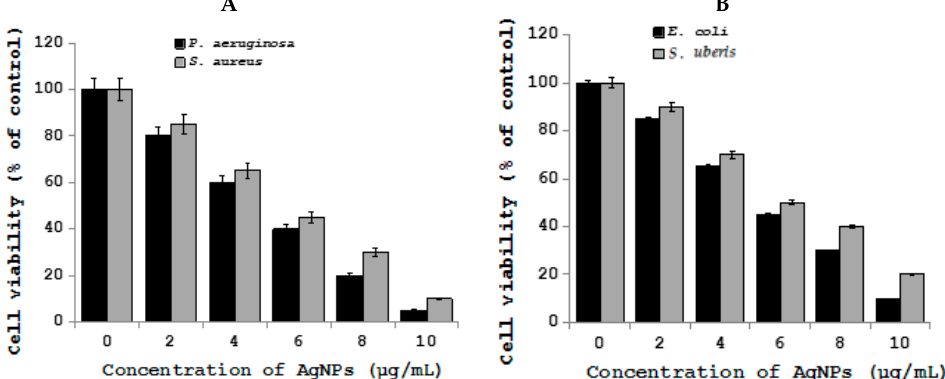
Figure 3. Effect of silver nanoparticles on S. aureus and P. aeruginosa , E. coli, and S. uberis from mastitis-infected goats. ( A ) Cell viability of S. aureus and P. aeruginosa treated with AgNPs. ( B ) Cell viability of E. coli, and S. uberis treated with AgNPs. Bacterials cells were incubated with various concentrations of AgNPs. Bacterial survival was determined at 24 h by a CFU (colony forming unit) count assay. The experiment was performed with various controls, including a positive control (AgNPs and NB, without inoculum) and a negative control (NB and inoculum, without AgNPs). The results are expressed as the means ± SD of three separate experiments, each of which contained three replicates. Treated groups showed statistically significant differences from the control group by Student’s t test ( p < 0.05).